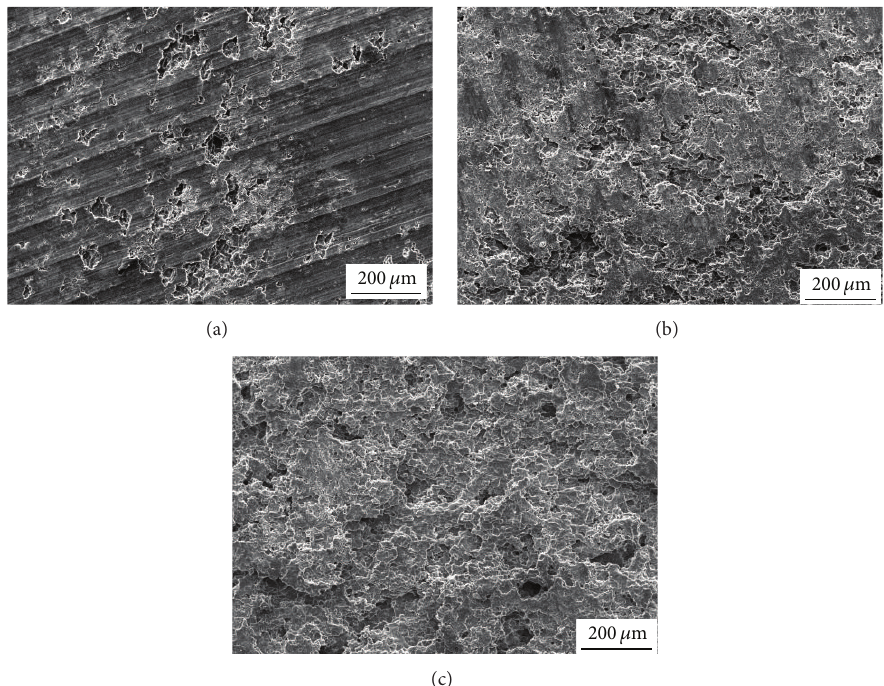
Figure 14: Corrosion morphologies of specimens without corrosion products after exposure for 1 month (a), 12 months (b), and 48 months (c).